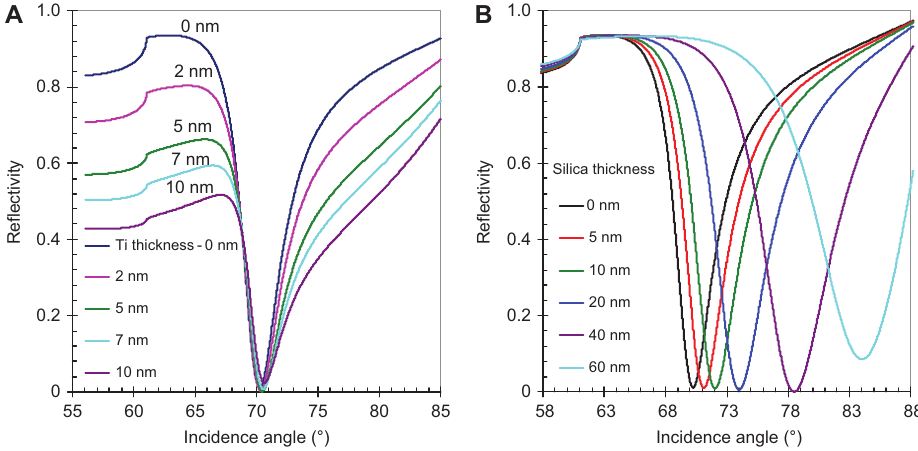
Figure 5 Infl uence of: (A) Ti adhesion layer between glass prism and metal fi lm; and (B) silica top layer of different thickness on per- formances of SPR sensor; parameters used for calculations: n = 2.32 + 3.08i, d = 0 – 10 n titanium Ti